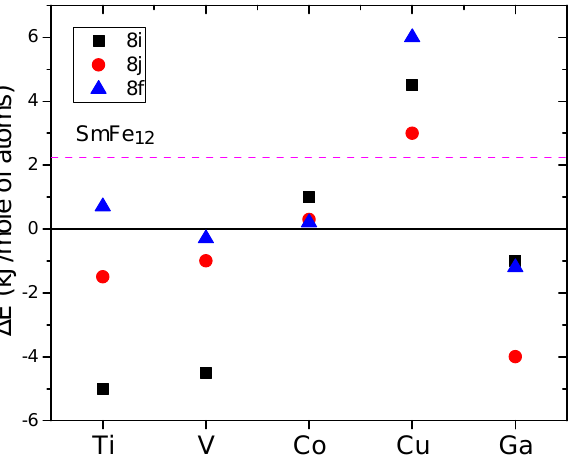
Figure 11. Calculated formation energy for SmFe 11 M ( M = Ti, V, Co, Cu, Ga) [113]. The magenta dashed line corresponds to formation energy of the hypothetical SmFe 12 energy.